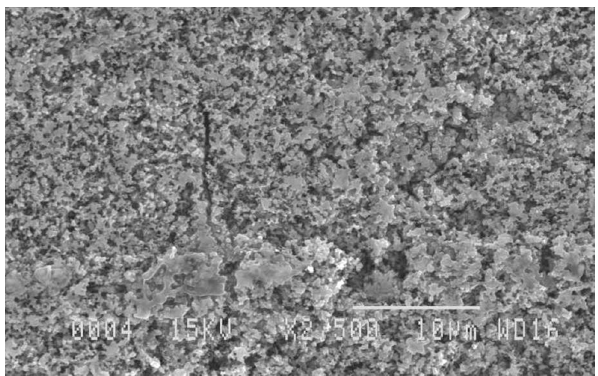
Figure 1. SEM image of the electrode surface. The microstructure profile of Al 2 O 3 layer on aluminium surface, created by etching and then anodizing an aluminium foil, was revealed by an SEM image with 2500x magnification.